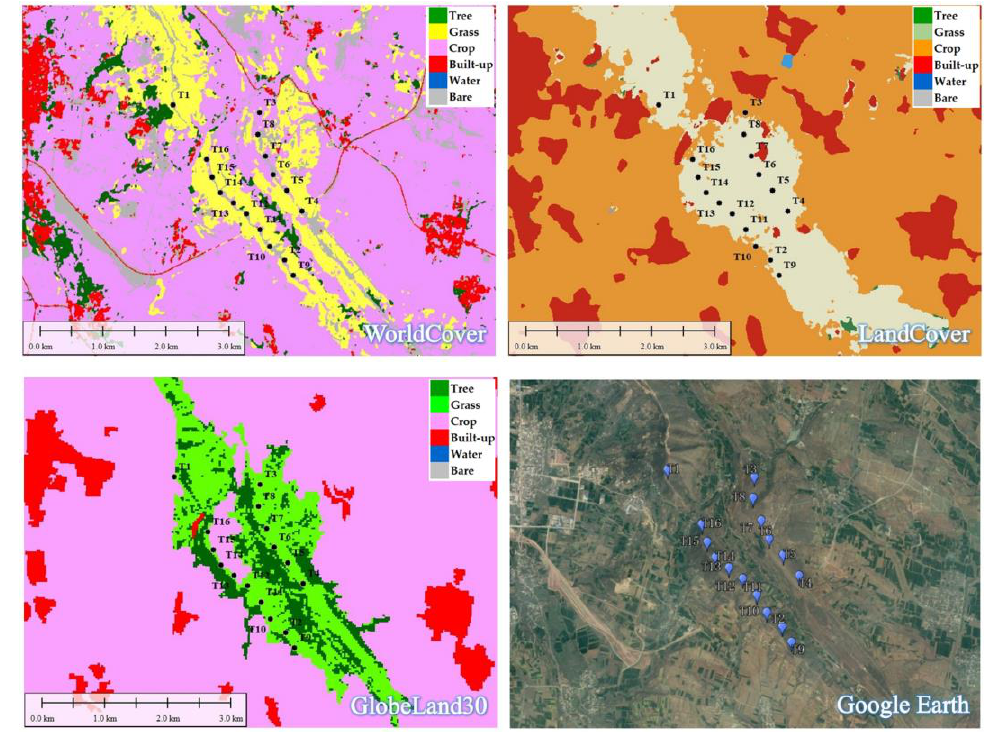
Figure 2. Close-angle comparison of different surface coverage data of wind farms.